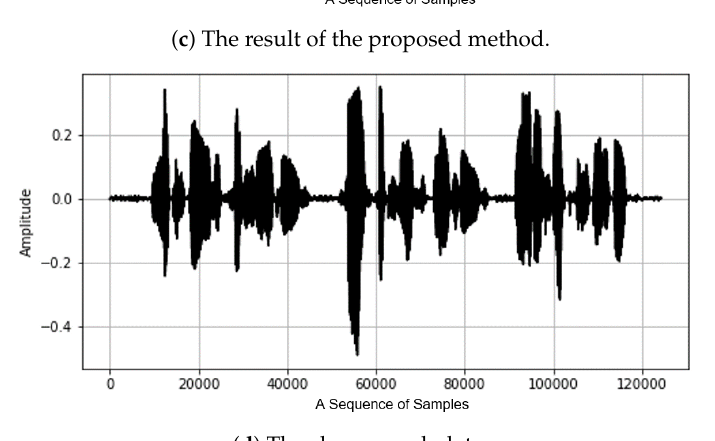
Figure 21. The denoised results of a sample p226 0